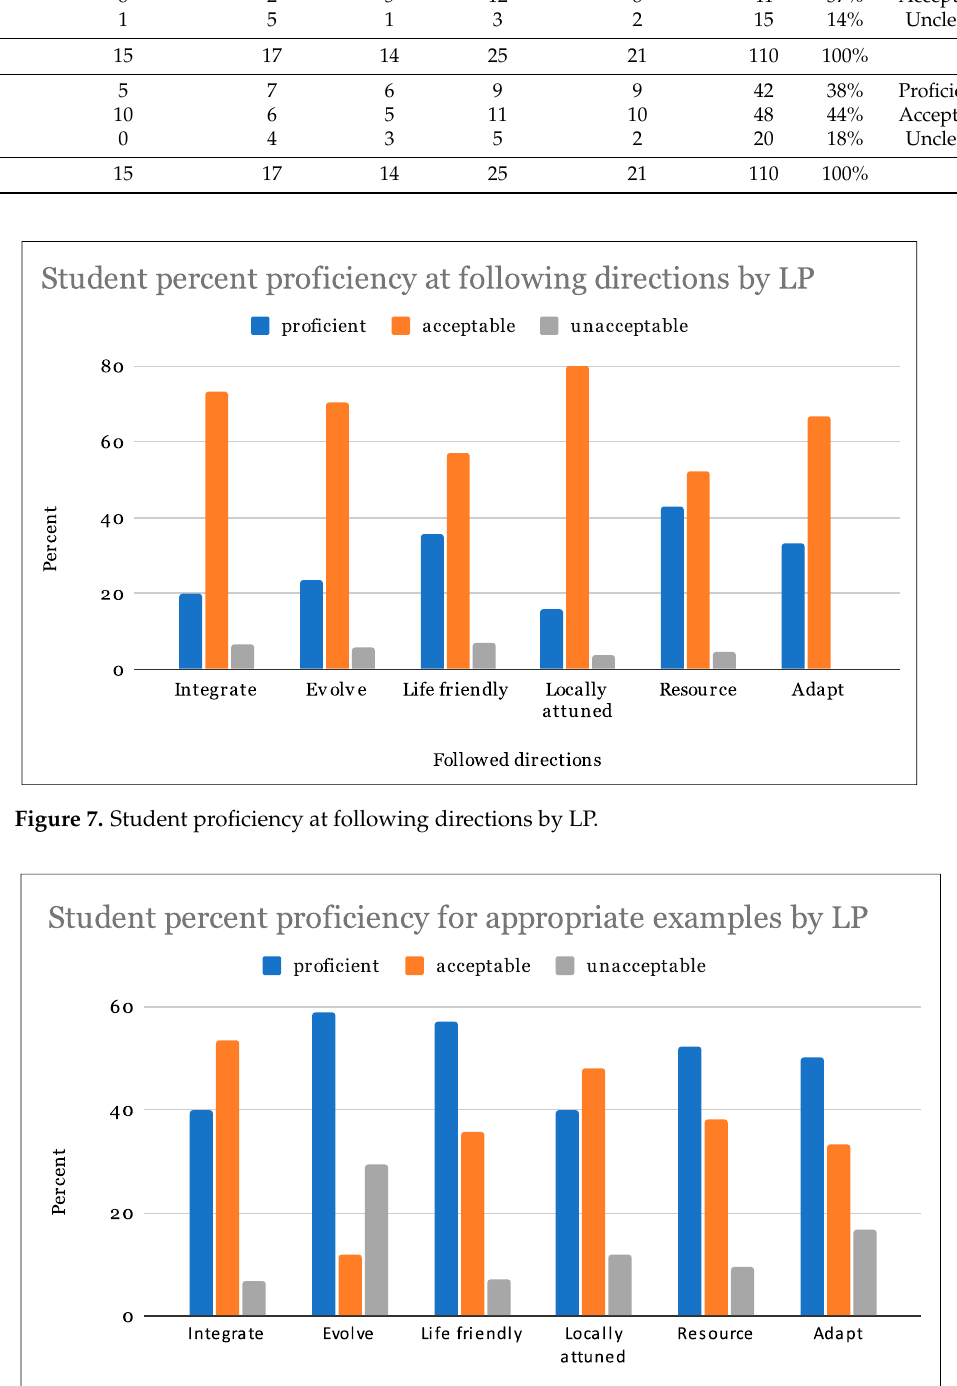
Figure 9. Student proficiency for clarity of explanation by LP. Table 4. Summary table single factor ANOVA for followed directions. SUMMARY Groups